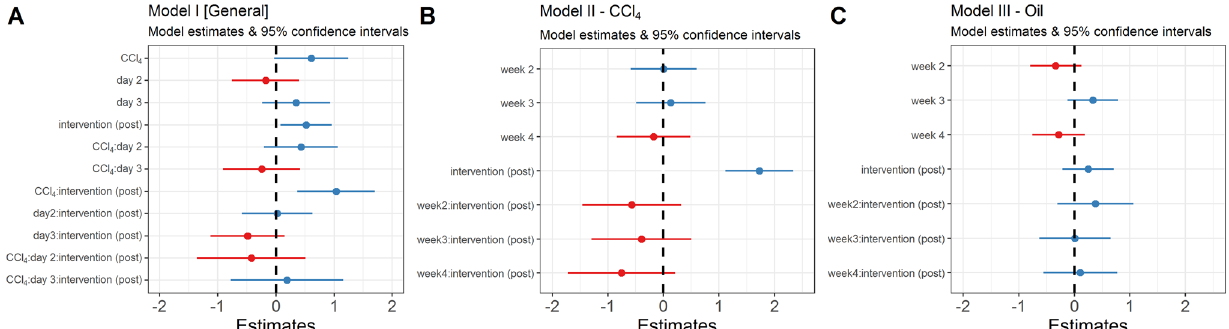
Figure 3. Coefficient estimates with 95% confidence intervals from linear the mixed-effects regressions of the orbital tightening variable (red/blue color: negative/positive coefficients). ( A ) General between-treatments model (default levels were Oil, day 1, and intervention (pre)) with significant coefficients for intervention (post) and CCl 4 :intervention (post). ( B ) Within-CCl 4 data over weeks (default level week = 1). No significant coefficients for week:intervention were found but there was evidence for a negative slope indicating habituation. Intervention, in general, was different from the default level in the CCl 4 group. ( C ) No significant coefficients were found in the control group